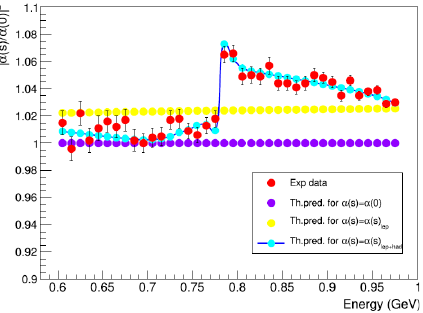
Figure 1. The square of the modulus of the running α ( s ) in units of α (0) (red points) [8] compared with the prediction (cyan) [9, 10] as a function of the dimuon invariant mass. Theoretical expectations in case of no running (violet) and only leptonic contribution (yellow) are also shown.